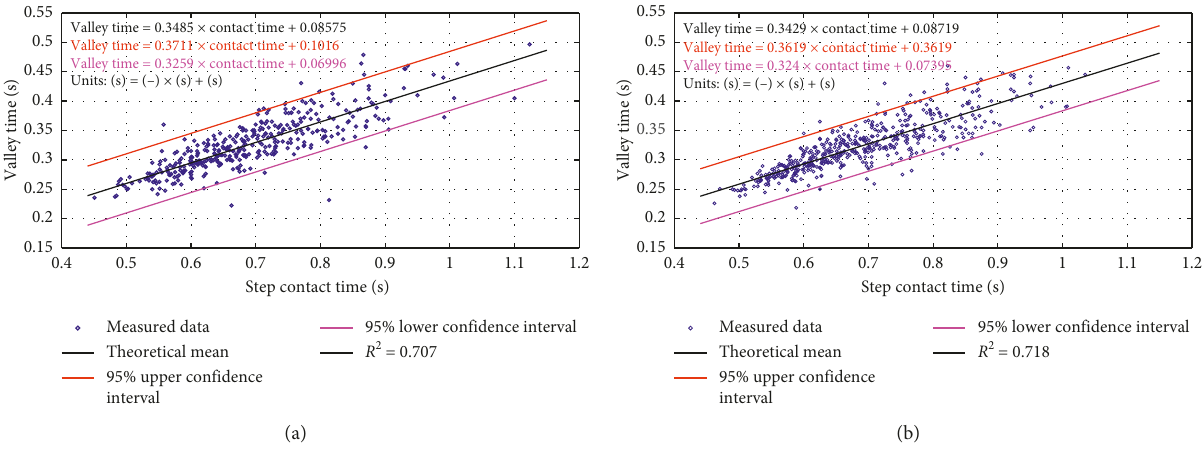
Figure 5: Statistical relationship between step contact time and valley time. (a) Right footfall; (b) left footfall.